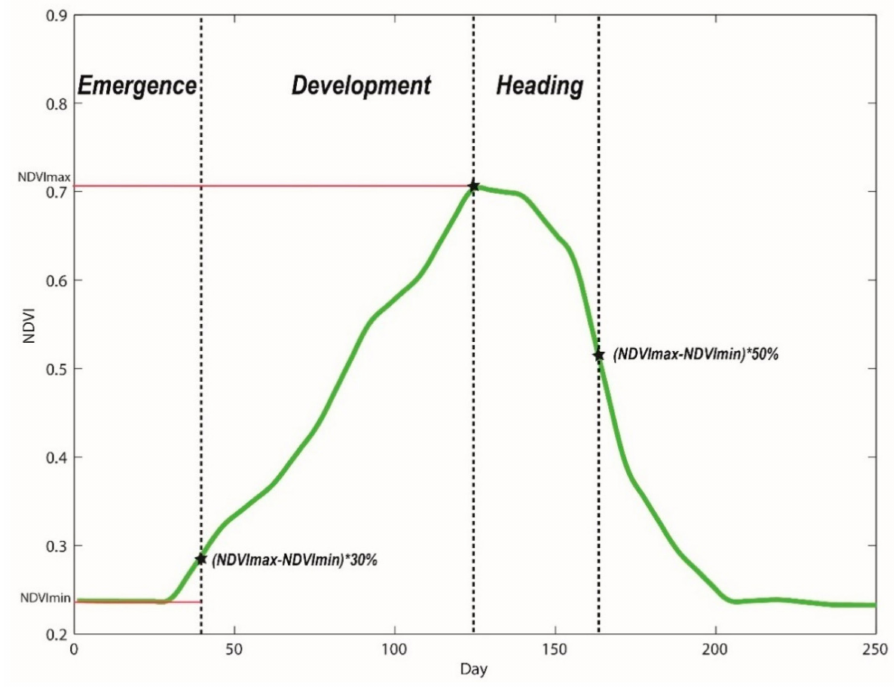
Figure A2. NDVI profile with key phenological stages during the 2016–2017 season for the Settat